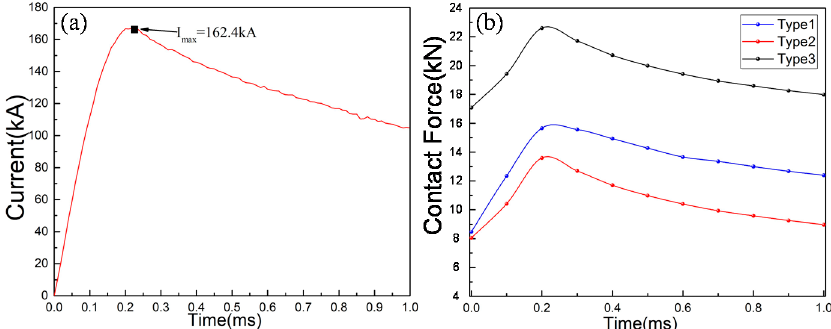
Figure 9. Total contact force vs. time. ( a ) Current used in simulation and test; ( b ) Contact force.